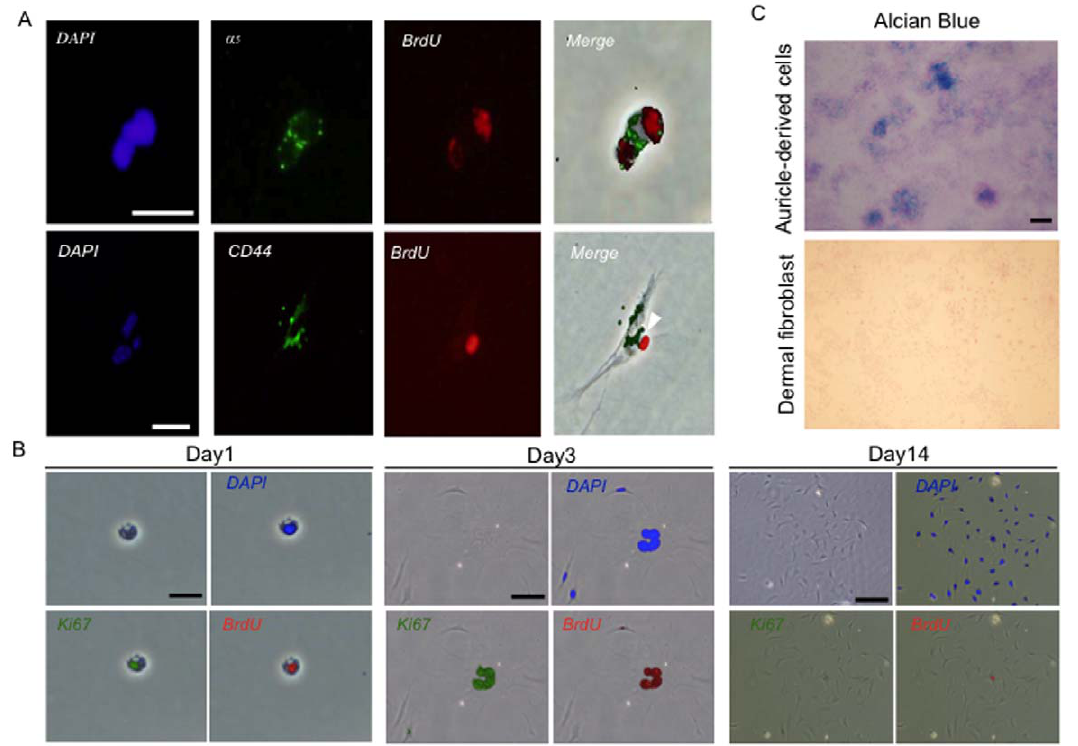
Figure 5. In vitro characterization of CD44 + integrin- a 5 + LRCs. (A) Immunocytochemistry of LRCs in vitro. Integrin- a 5 and CD44 were co- expressed in BrdU-labeled cells. CD44 staining: scale bar=20 m m; integrin- a 5 staining: scale bar=40 m m. Original magnification: 6 200. (B) Colony formation of LRCs. Cells from 24-week-old mice, which were injected with BrdU as E17 to E19 fetuses, were harvested from mice auricle following collagenase digestion. Colony assay was performed to examine the clonogenicity of LRCs. Cells were stained at 1, 3 and 14 day after plated. Clonal colonies were stained with antibodies against DAPI, Ki-67 and BrdU. Scale bars=20 m m or 100 m m (C) Alcian blue staining of cells isolated from auricular cartilage or dermal fibroblasts. Scale bar=200 m